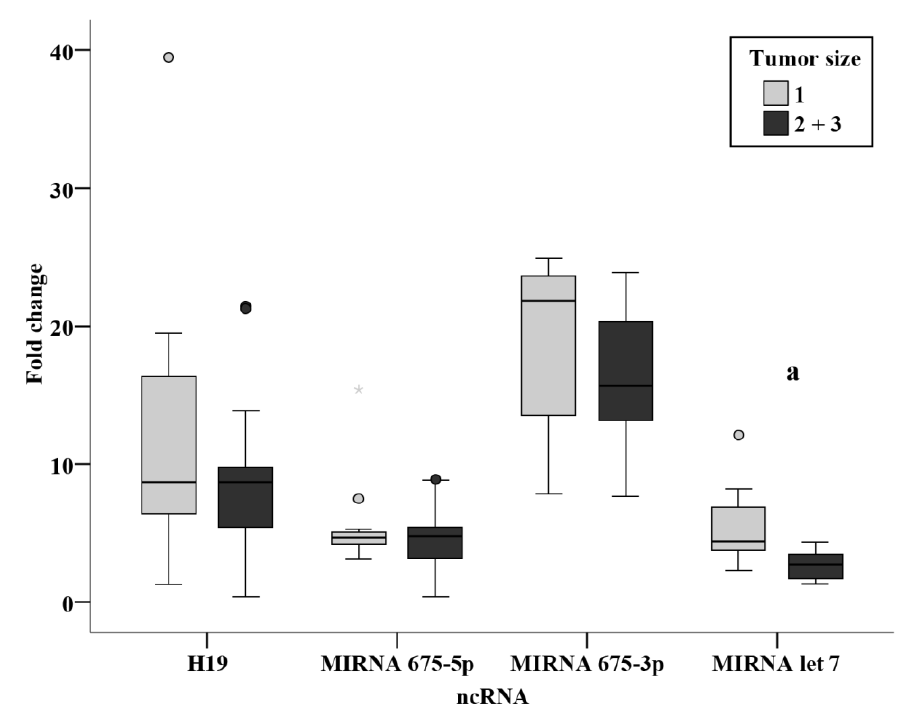
Figure 11. Relation between ncRNA and tumor size in presurgery BC patients, *—Extreme value: a—Significant between ncRNA and tumor size using Mann Whitney test. No statistically significant association was found between the clinicopathological parameters and the circulating levels of ncRNAs in the prechemotherapy BC patients. (Figures 12–14).